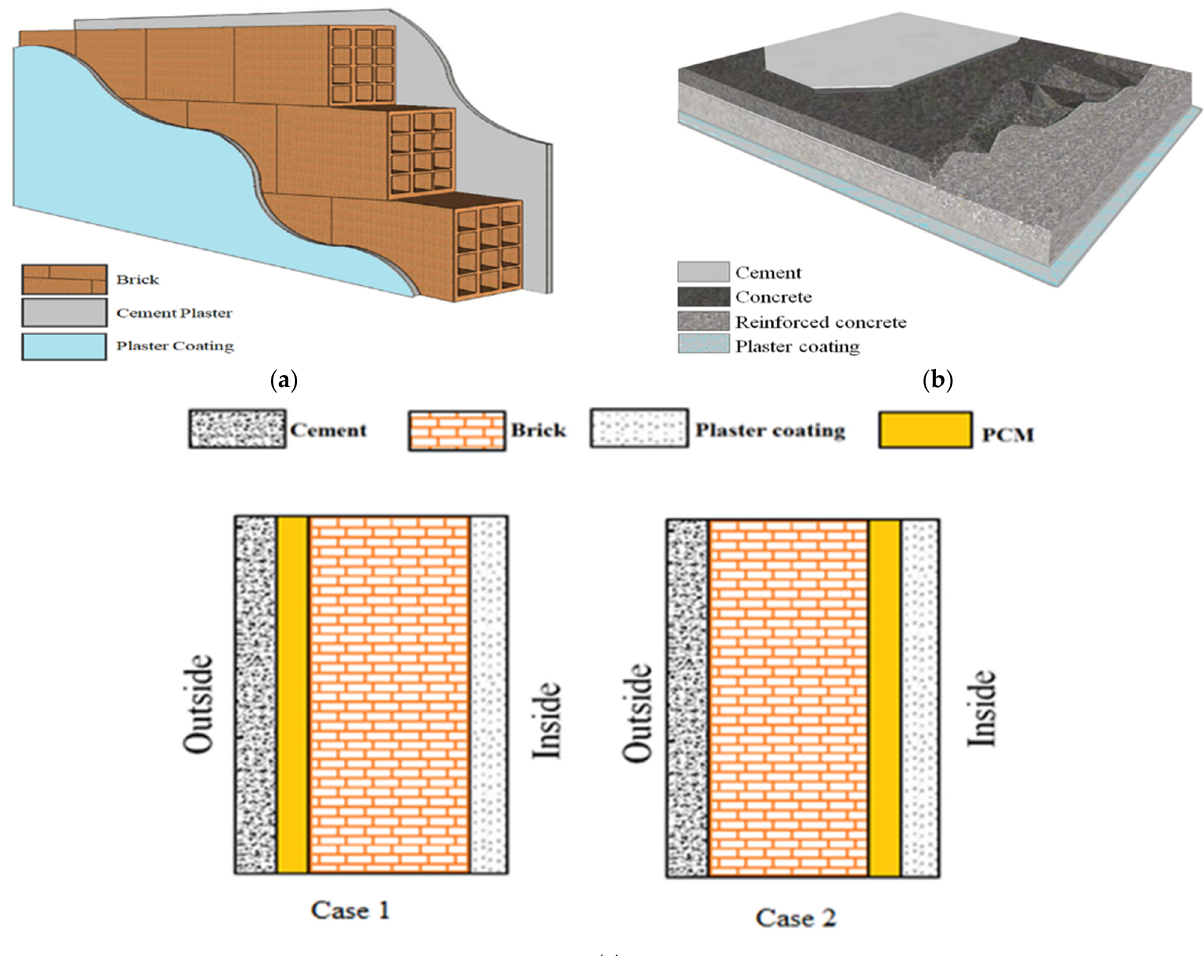
Figure 5. Schematic representation of ( a ) external wall, ( b ) roof, and ( c ) PCM integration.